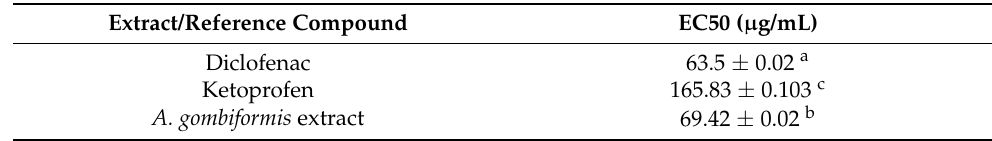
Figure 4. In vitro anti-inflammatory effect of A. gombiformis extract. Table 3. In vitro anti-inflammatory effect of A. gombiformis extract and reference compounds.EC50 values are expressed as means ± SD of three replicates. The same subscript letters are not signifi- cantly different following the Tukey’s honestly significant difference post hoc test at p < 0.05. Extract/Reference Compound